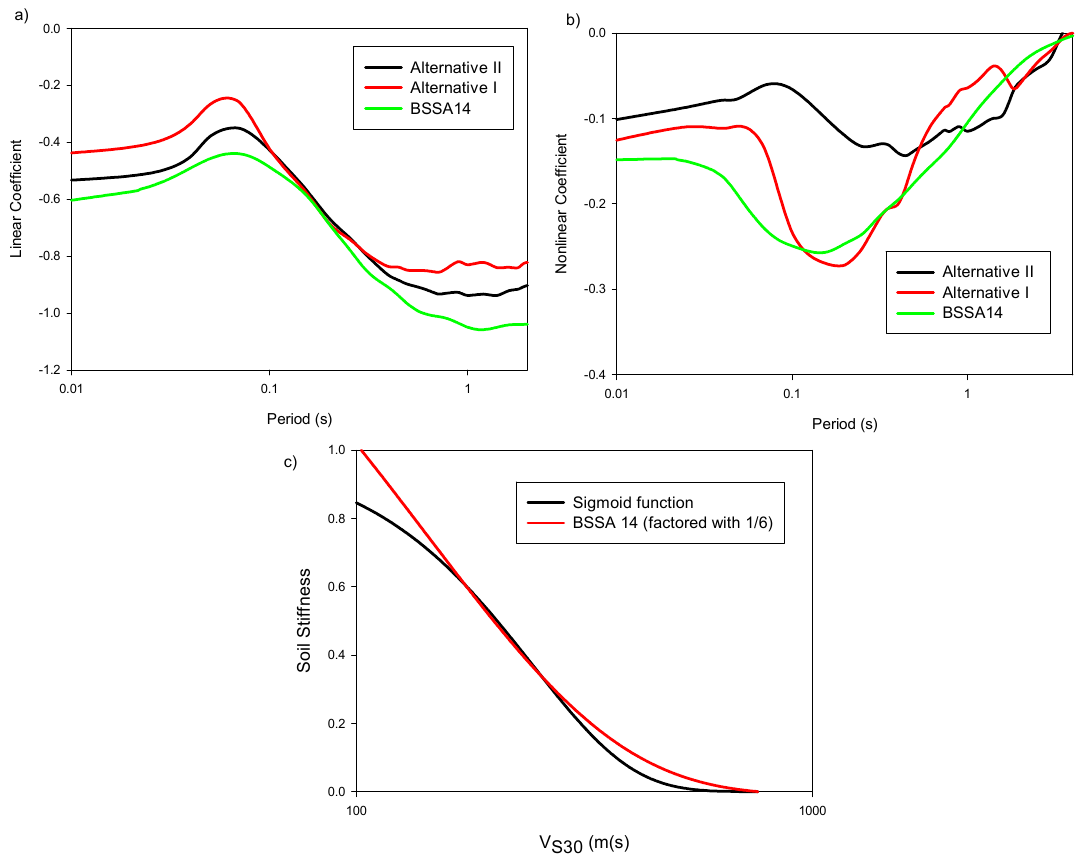
Figure 3. Comparison of ( a ) linear and ( b ) nonlinear site model coefficients computed with alternative functional forms. The coefficients given in BSSA14 are also included in these plots; ( c ) the soil stiffness term in the BSSA14 functional form and the proposed Gompertz sigmoid function are compared.